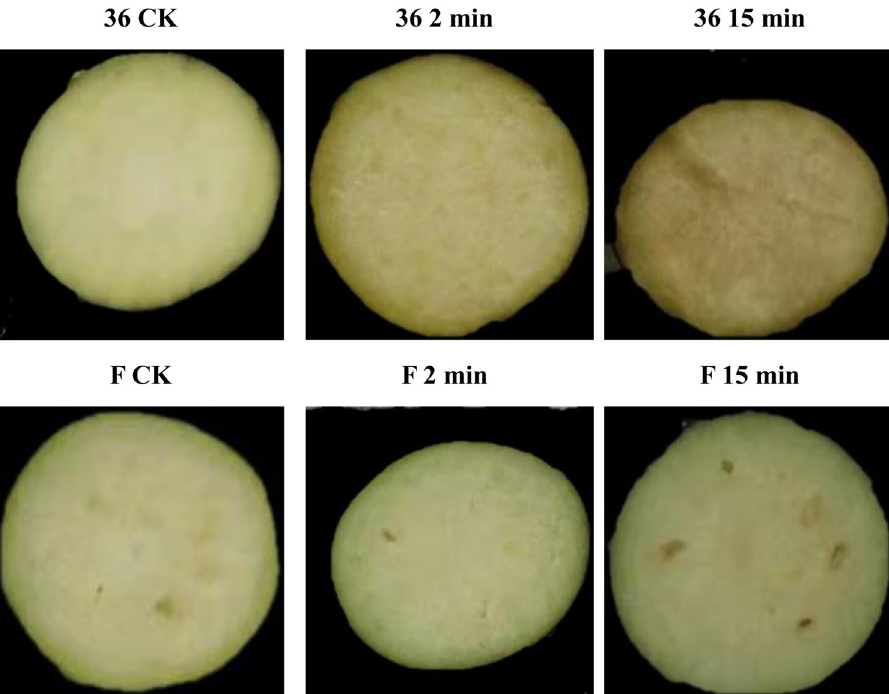
Figure 1. The browning degree of browning-sensitive (36) and browning-resistant (F)